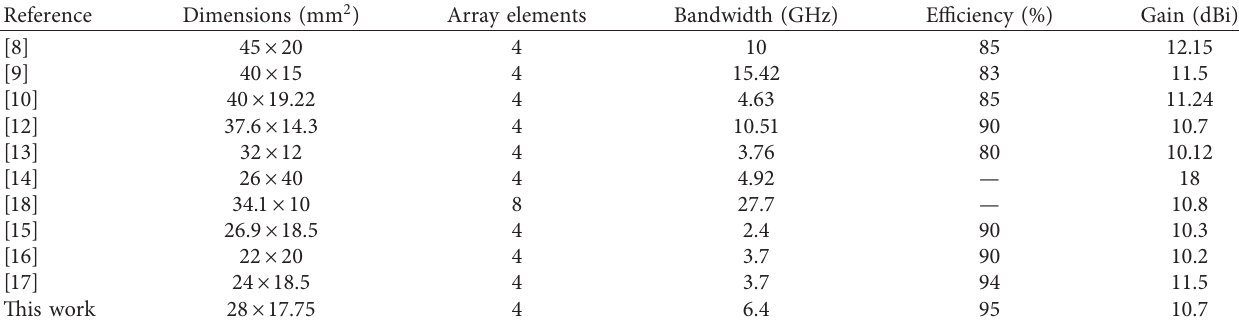
Table 1: Comparison between the proposed array and previously published literature.